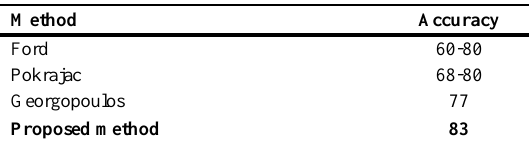
Table 3. Comparison of obtained accuracy (%) using proposed method with a list of previous